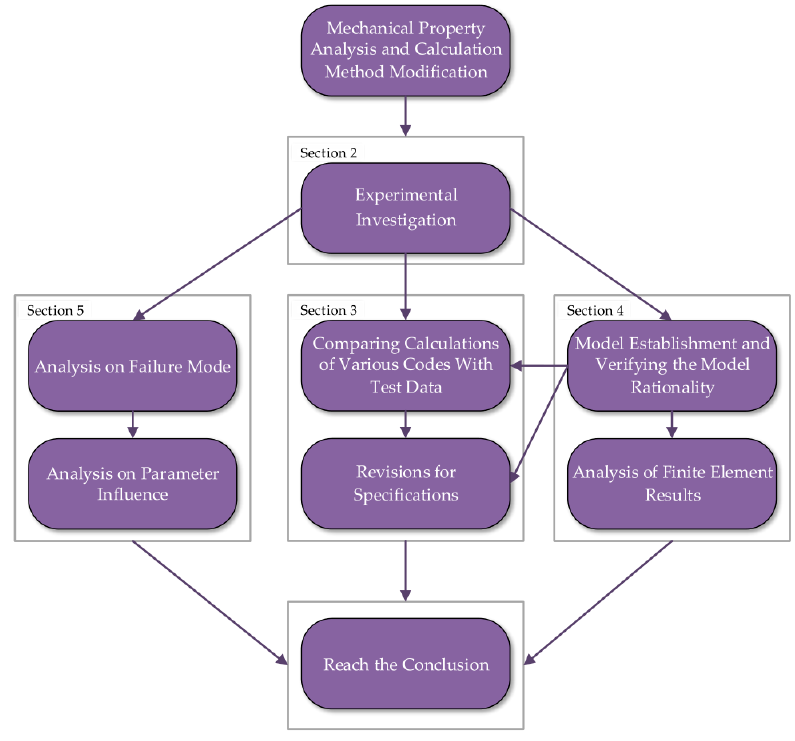
Figure 1. The main research methods and processes.